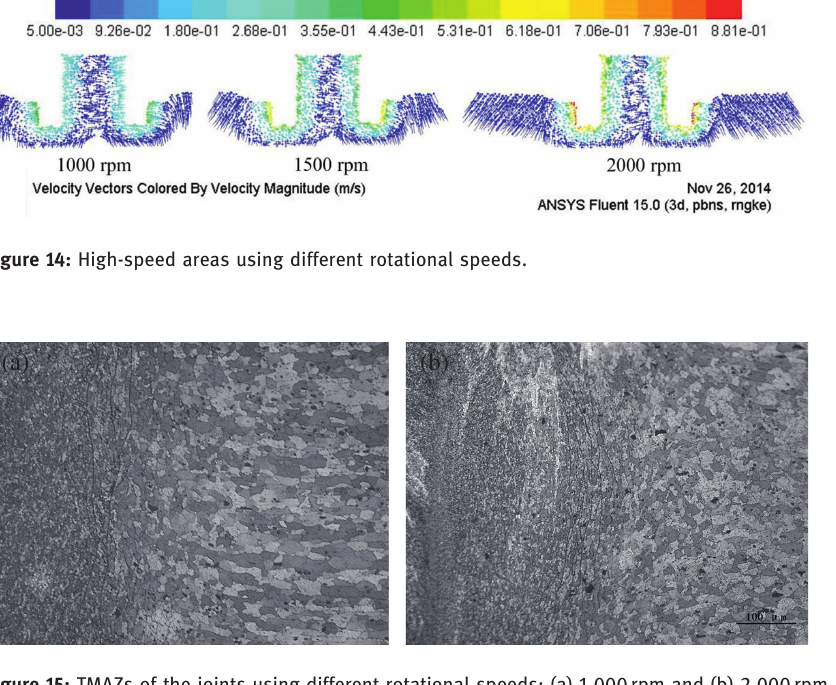
Figure 15: TMAZs of the joints using different rotational speeds: (a) 1,000rpm and (b) 2,000rpm.